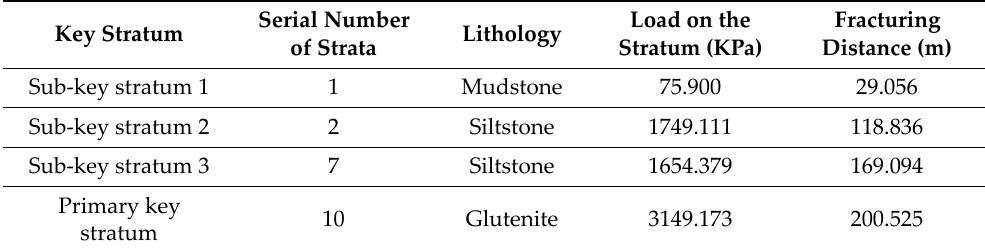
Table 5. Calculation results of key strata of working face W8203 of Tashidian Erjingtian